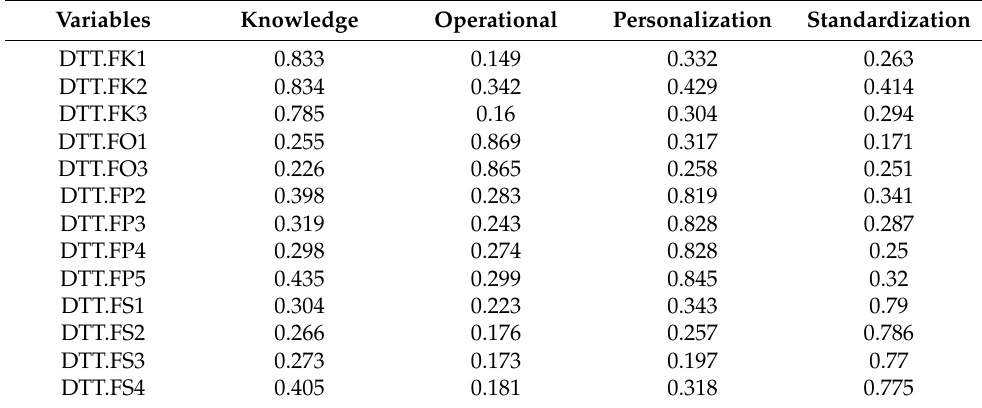
Table 10. Cross loading with discriminant